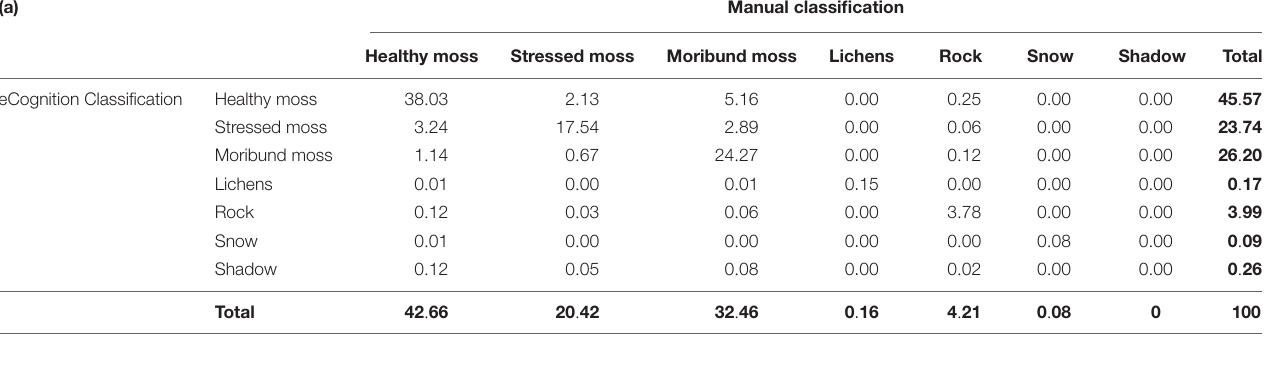
TABLE 1 | Comparison of test mosaic classification by eCognition and manual classification by expert.